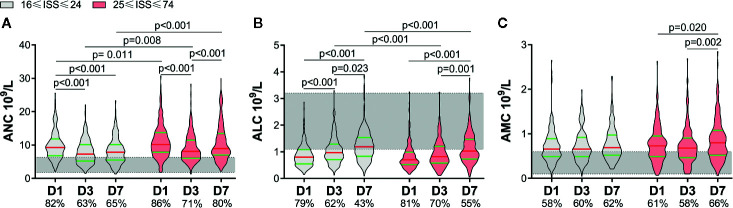
Alterations of circulating immune-cell counts in severe-trauma patients within 7 days. The proportion of patients with a value above the upper limit of the normal range (shaded area) of the absolute neutrophil count (ANC) and absolute monocyte count (AMC) or below the lower limit of the normal range of the absolute lymphocyte count (ALC) are shown on the x-axis. An increase in the ANC and AMC (A, C), and decrease in the ALC (B) were common in severe-trauma patients. ISS, Injury Severity Score; D1, day-1; D3, day-3; D7, day-7.